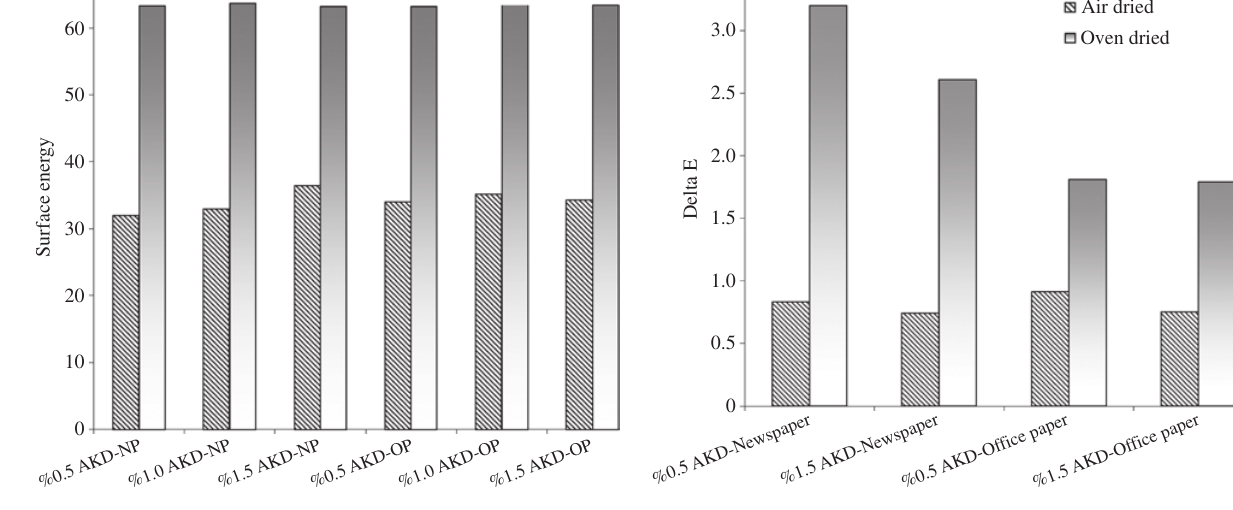
Figure 5: Δ E numbers of